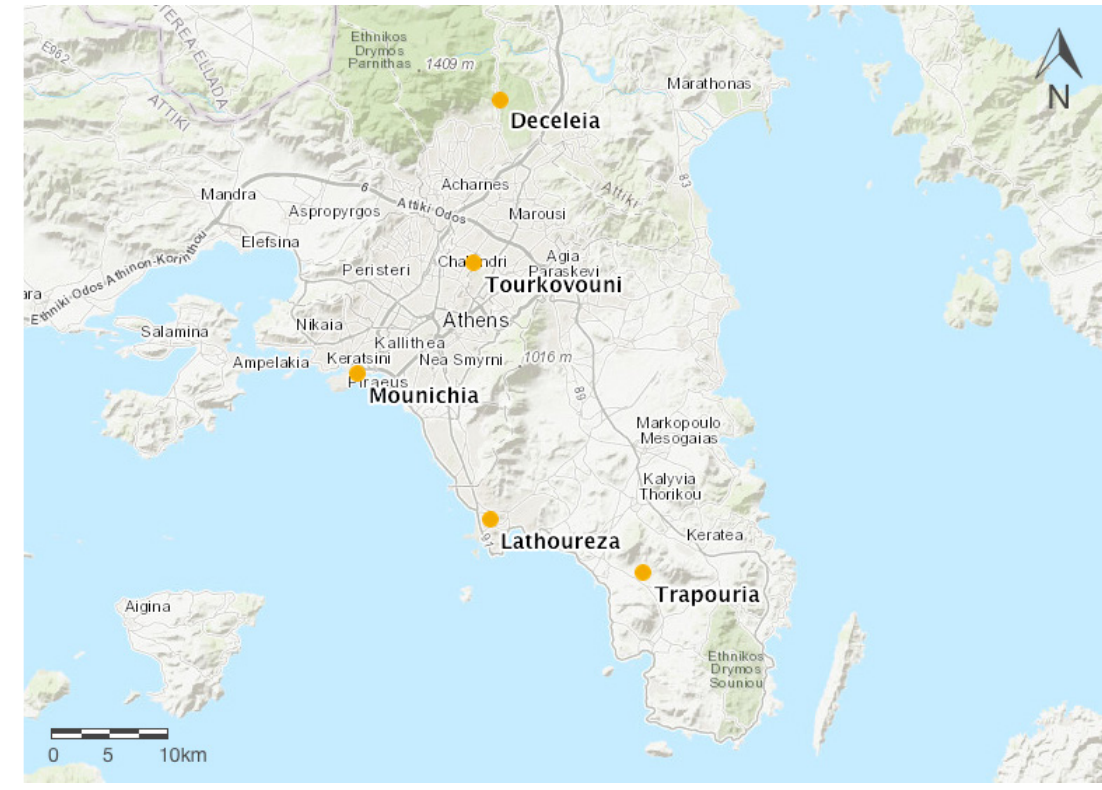
Figure 1. Map of Attica with the indications of the cult places of Deceleia, Tourkovouni, Lathoureza, Trapouia, and Mounichia (M.